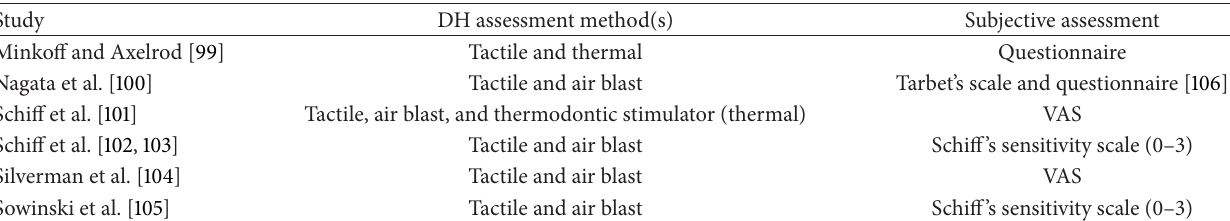
Table 8: The different types of DH assessment used in the included